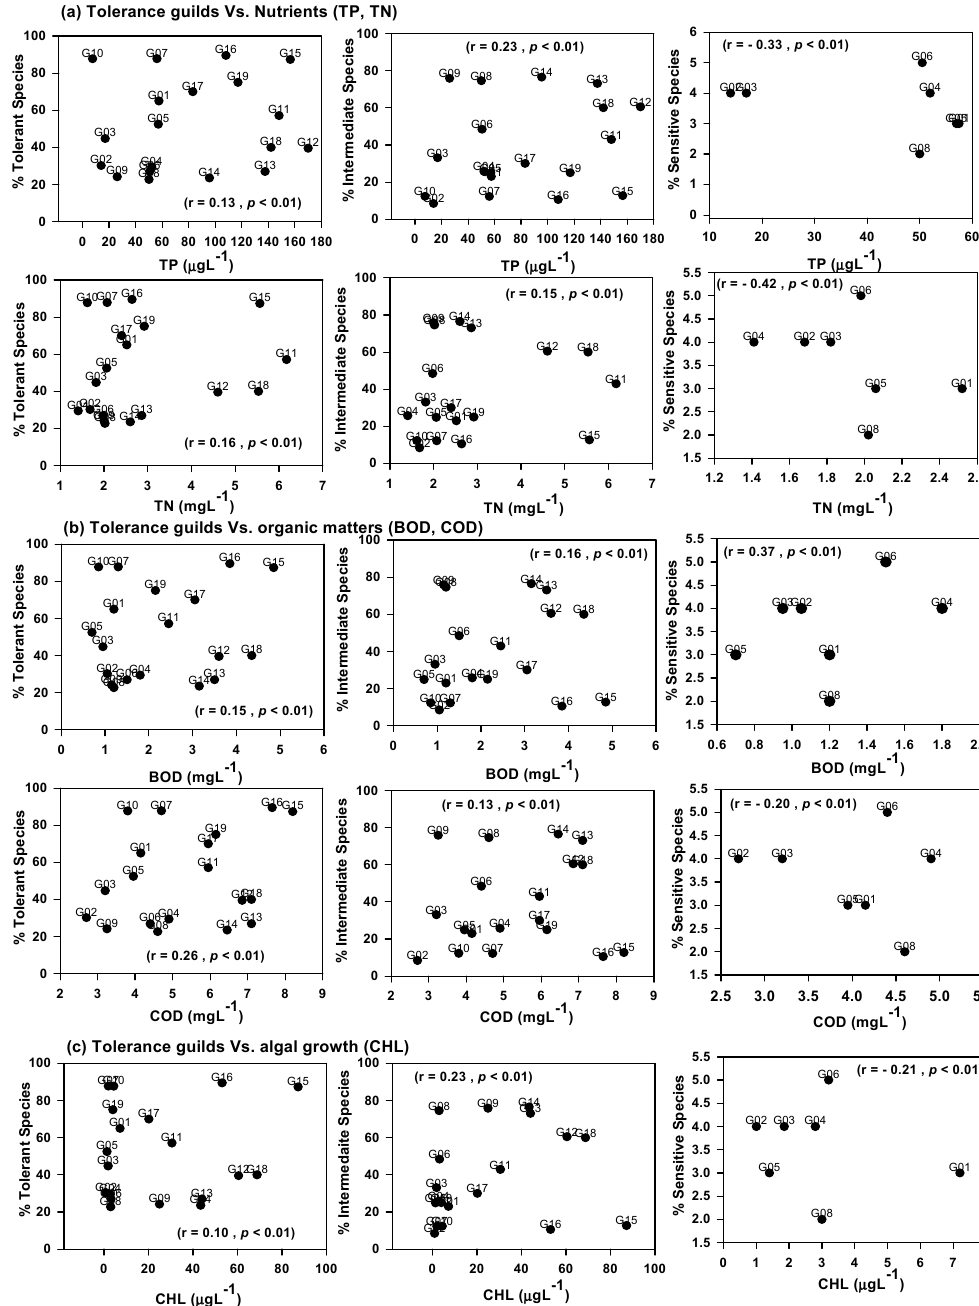
Figure 6. Tolerance guild analysis with water quality factors (TN—total nitrogen, TP—total phosphorus, N:P ratios, BOD—biological oxygen demand, COD—chemical oxygen demand, CHL—chlorophyll).